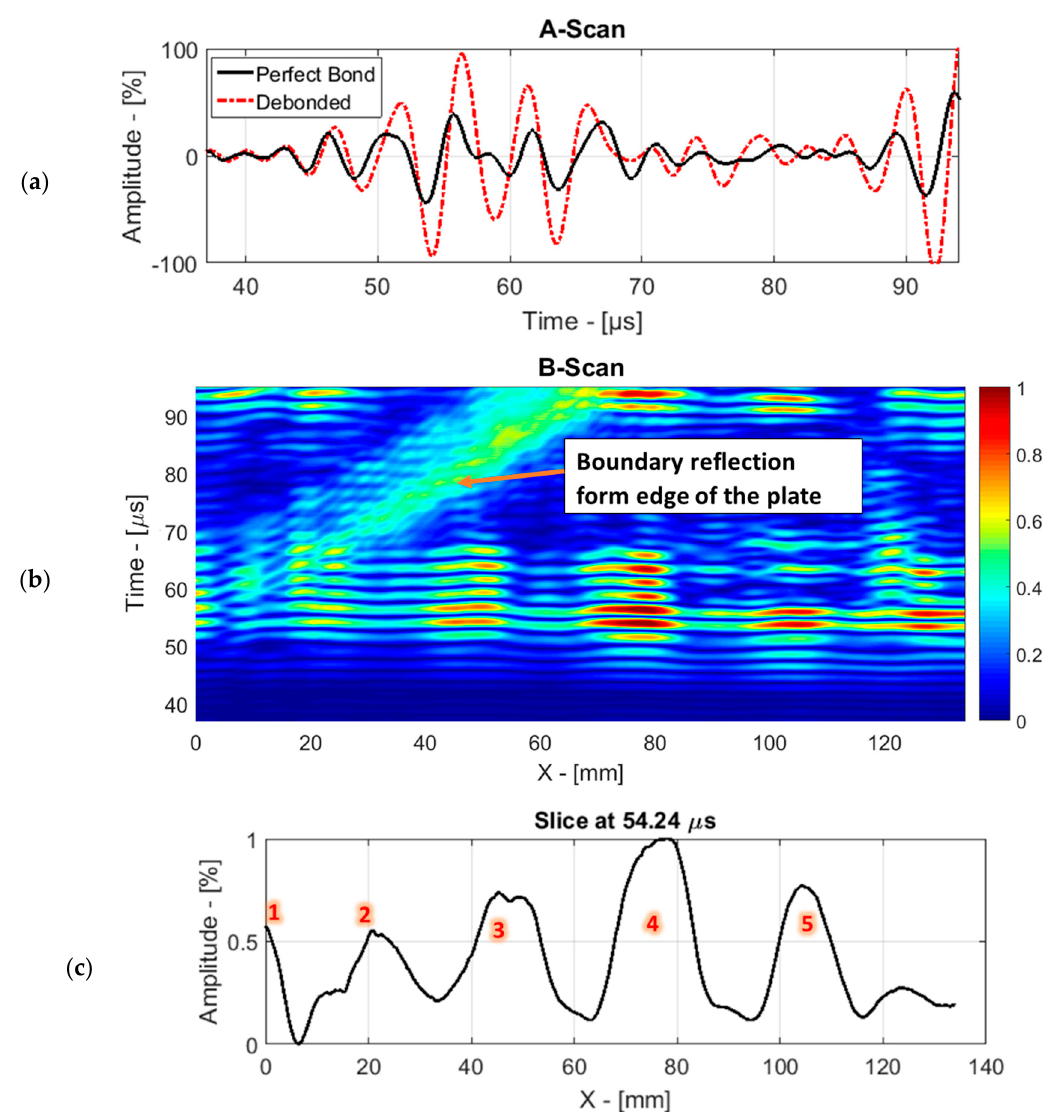
Figure 19. Contact-to-contact guided wave results: ( a ) A-scan; ( b ) B-scan; ( c ) slice at time = 54.24 µs.